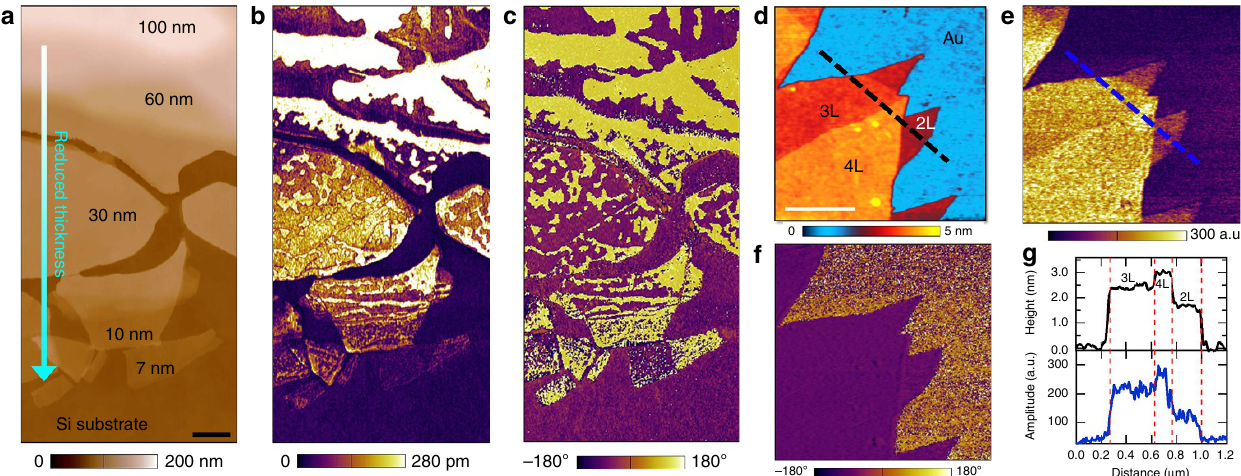
Figure 2 | AFM and piezoresponse images of CIPS with different thicknesses. ( a – c ) AFM topography ( a ) PFM amplitude ( b ) and PFM phase ( c ) for CIPS flakes ranging from 100 to 7nm thick, on doped Si substrate. Scale bar in a , 1 m m. ( d , e ) AFM topography ( d ) PFM amplitude ( e ) and phase ( f ) of 2–4 layer thick CIPS on Au coated SiO 2 /Si substrate. Scale bar in d , 500nm. ( g ) the height (black) and PFM amplitude (blue) profile along the lines shown in d and e , respectively. L,